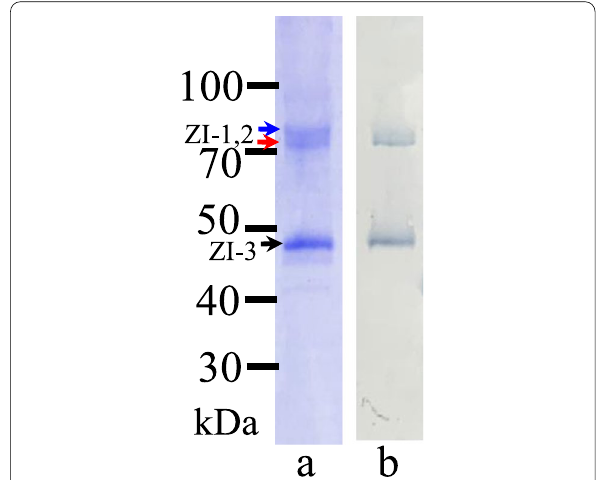
Fig. 4 Immunoreactivity of the anti-mZPC5 antibody and detection of mZPC5 in the chorion lysates. a : CBB-stained proteins in the chorion lysate, b : proteins immunoreactive to anti-mZPC5 antibody. The numbers (30–100) on the y-axis represent the molecular masses of the detected proteins in kilodaltons (kDa). The top (blue), middle (red), and bottom (black) arrows represent the positions (molecular masses) of ZI-1, ZI-2, and ZI-3, respectively. ZI-1 and -2 fall between 100 and 70 kDa, and ZI-3 falls between 50 and 40 kDa on the